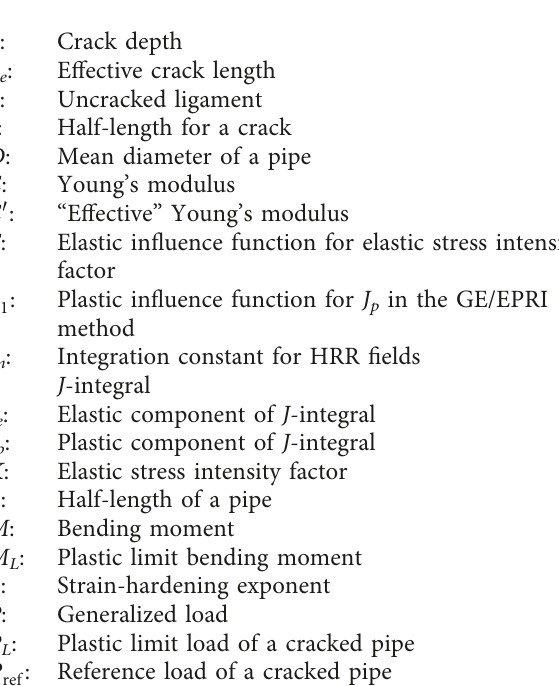
100, a / t 0.2, and θ / π 0.04: (a) X70; (cid:31) (cid:31) (cid:31)